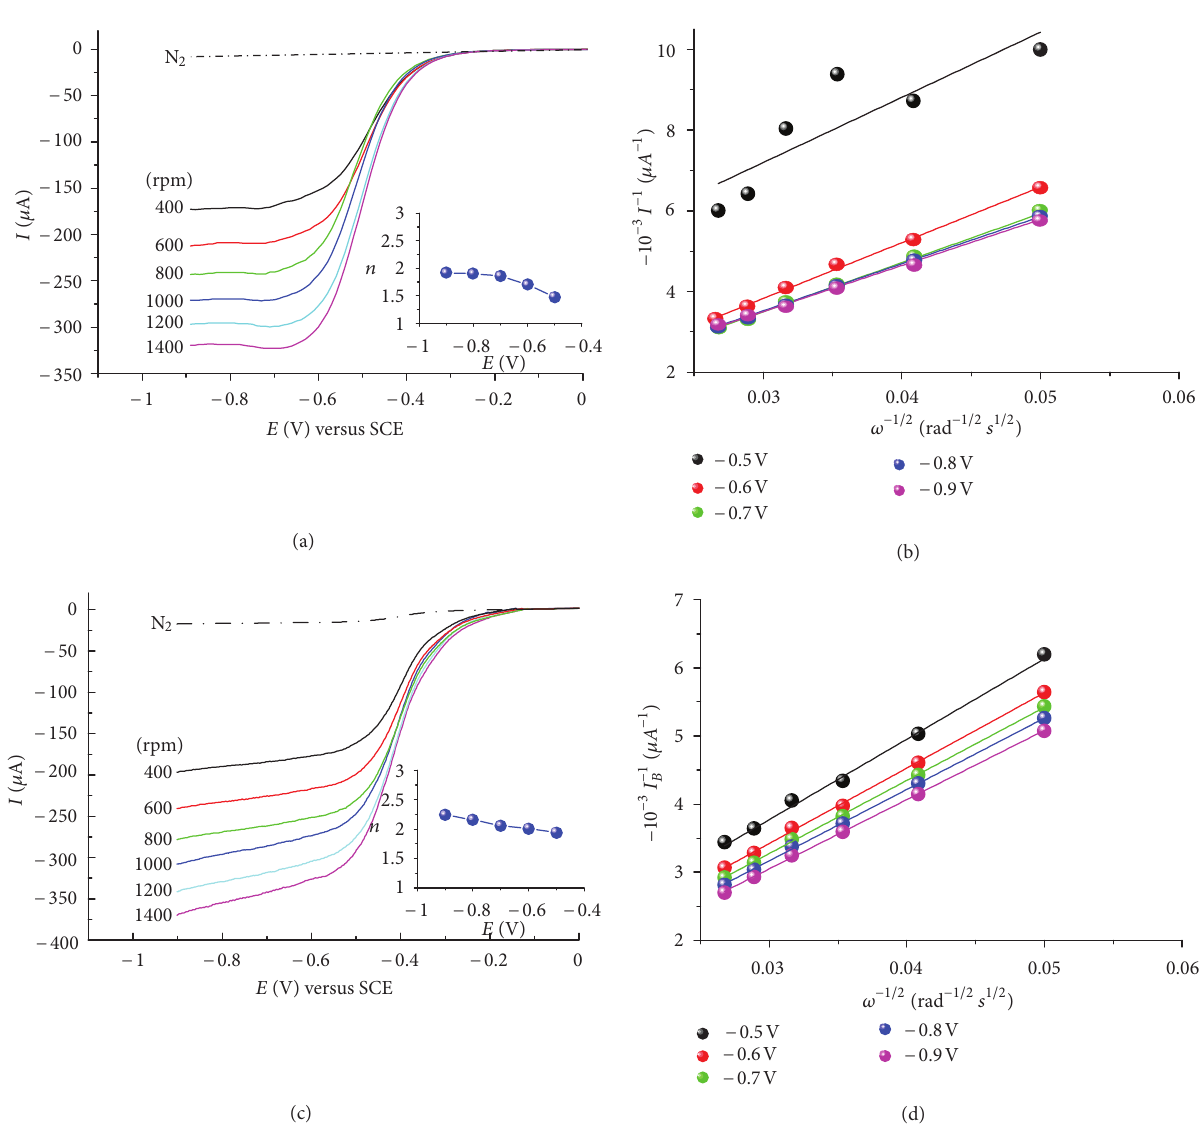
saturated buffer solutions at 0.4 V are presented in Figure 8(a). As can be seen, the Nyquist plots present the sup- pressing semicircle arcs in the high-frequency region and almost straight lines in the low-frequency region for all four cases. e respective semicircle parameters correspond